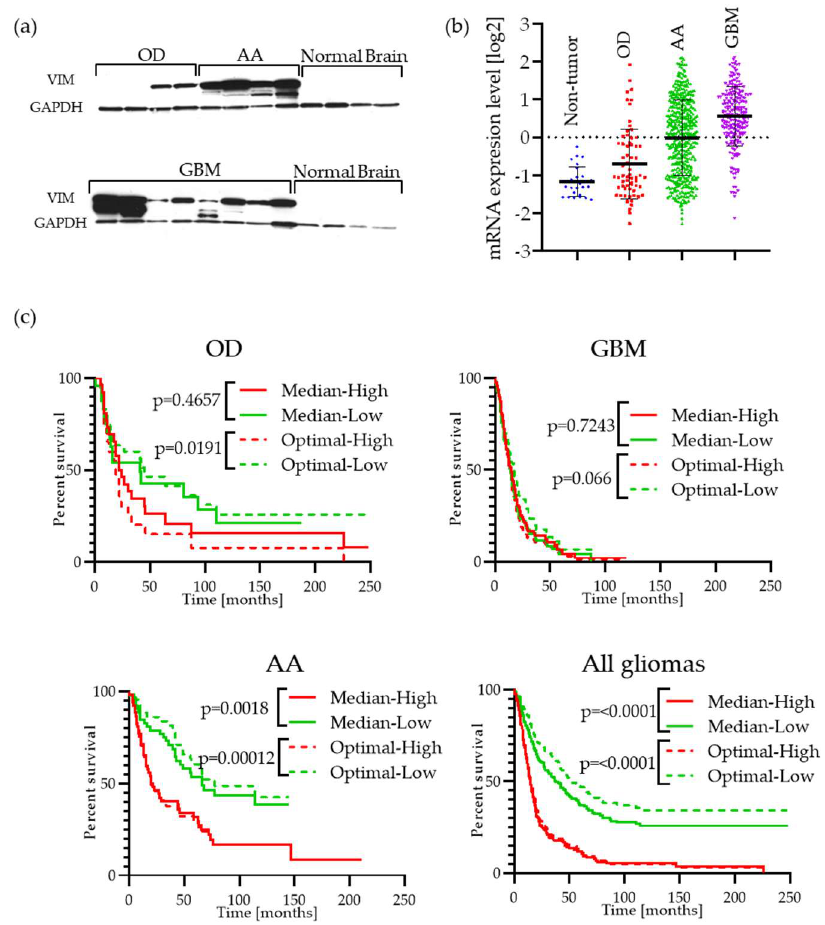
Figure 2. Expression of vimentin in malignant gliomas: ( a ) Western blot analysis of vimentin expression in human patient malignant glioma surgical specimens: OD—oligodendroglioma, AA—anaplastic astrocytoma, GBM—glioblastoma multiforme; compared with normal brain; ( b ) the mRNA transcript levels of vimentin according REMBRANDT database (http://www.betastasis.com/glioma/rembrandt), sample size: non-tumor n = 29, OD n = 67, AA n = 460, GBM n = 220; ( c ) survival curves based on high versus low vimentin mRNA expression obtained from the REMBRANDT database. The solid lines present data for samples with levels higher (red) or lower (green) than median of dataset; the dashed lines presents data for samples divided into two groups (higher—red or lower—green) based on the “optimal cut-off” algorithm [22].